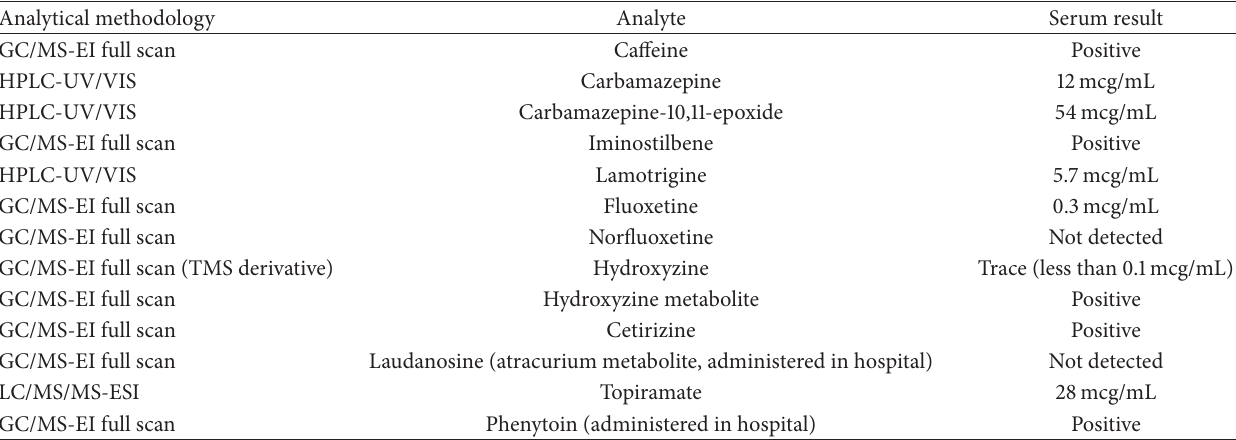
Table 2: Antemortem serum drawn on hospital day #3, morning (processed